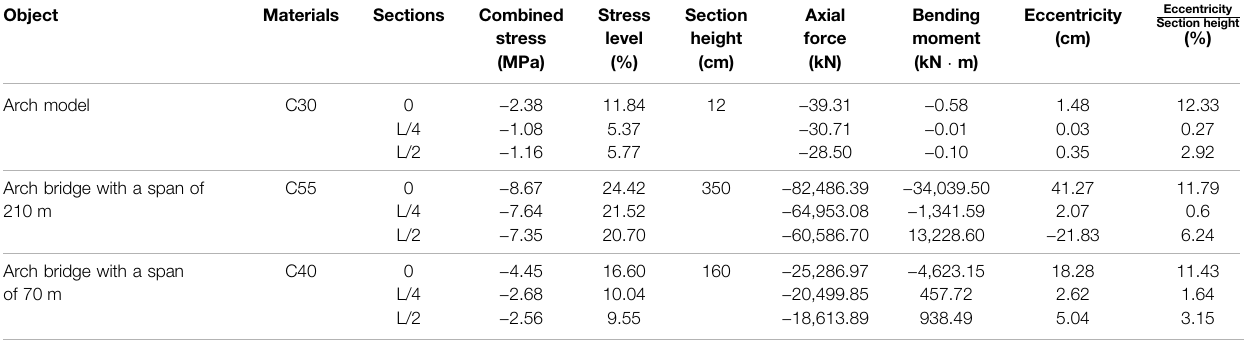
TABLE 1 | Comparison of the stress state between real bridges and the arch